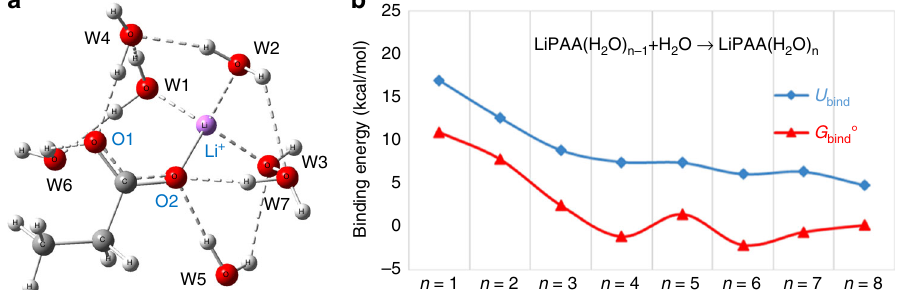
Fig. 2 Evolution of LiPAA solvation sphere. a Binding order of water molecules with LiPAA as calculated by M08-HX/MG3S/SMD. b Binding energies ( U bind ) and standard-state binding free energies ( G bind °) of LiPAA(H 2 O) n ( n = 1 – 8) as calculated by M08-HX/MG3S/SMD